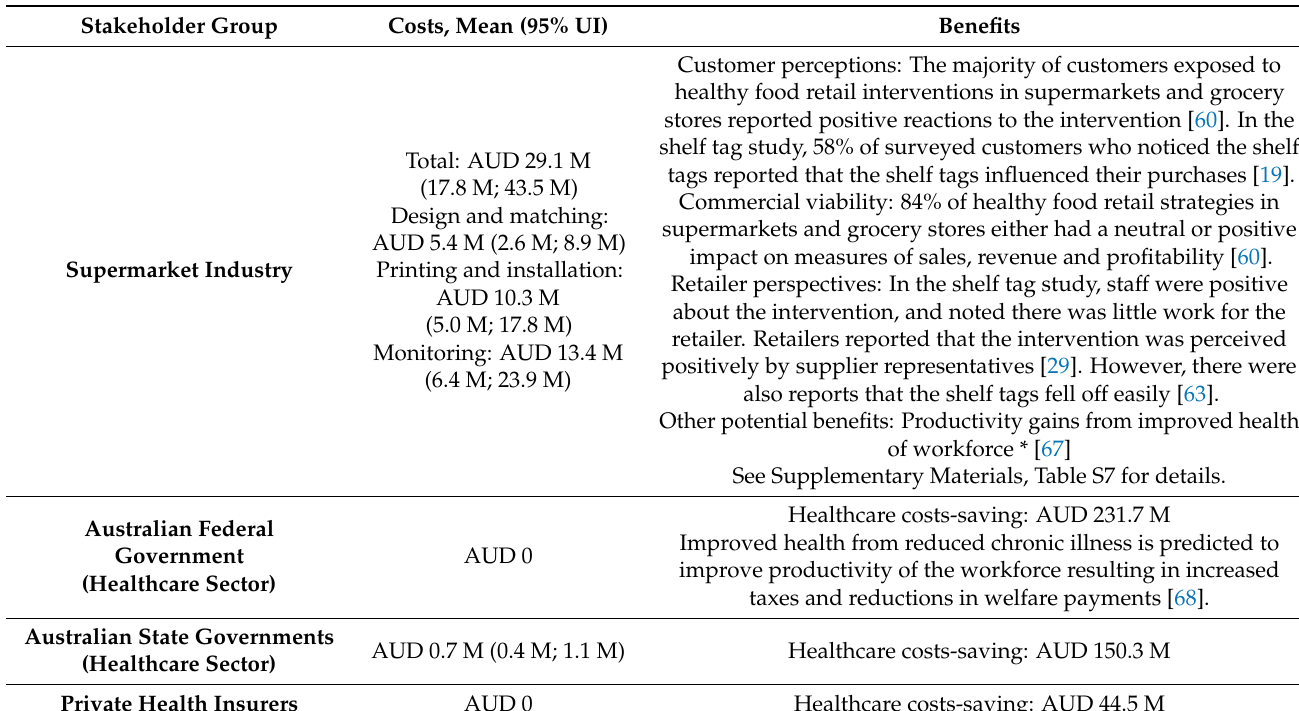
Table 4. Cost-effectiveness results, mean (95%